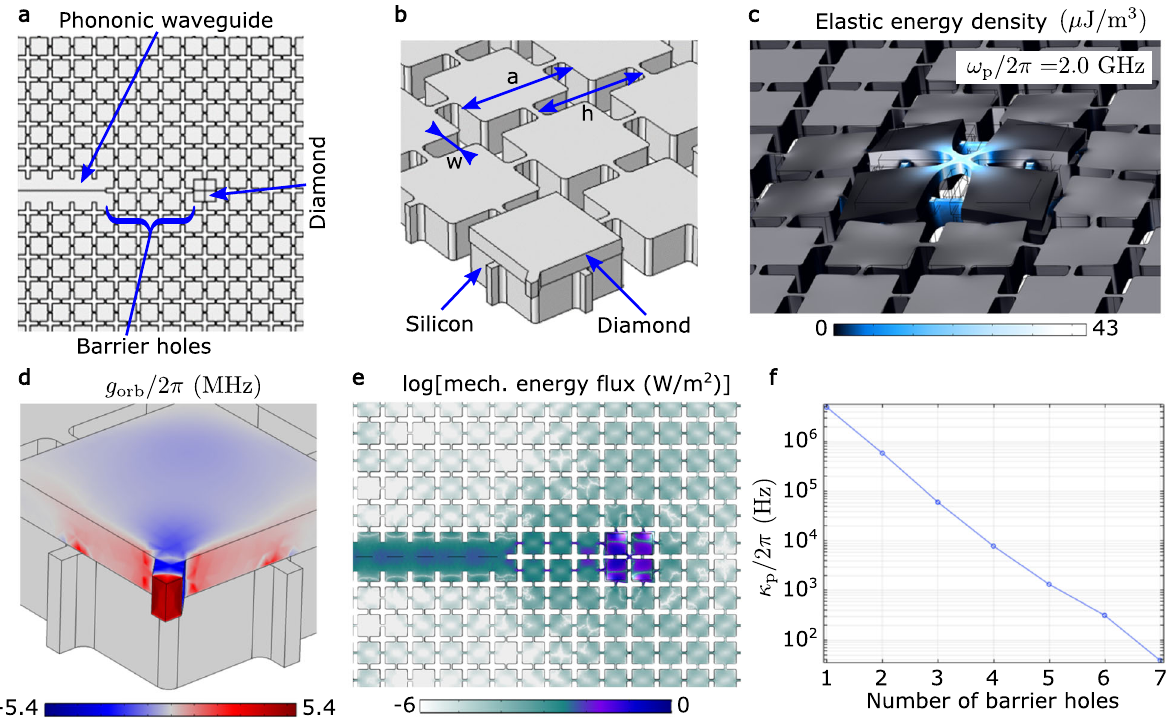
Fig. 2 Silicon phononic cavity. a A mechanical resonator embedded in a phononic crystal is separated from a phononic waveguide by a number of barrier holes. It is capped by a thin diamond layer placed over the silicon layer. b A close-up of one quarter of the silicon-diamond structure with dimensions a = 800 nm, h = 0.94 a , and w = 0.2 a . The silicon (diamond) layer thickness is t Si = 250 nm ( t D = 100 nm). The width of the thin rectangular diamond interconnects is w D = 70 nm. c The elastic energy density of the cavity mode is concentrated in the thin constriction of the diamond layer. The geometry of the cavity is arti fi cially distorted along the coordinate of the mechanical mode. d The coupling rate between the mechanical mode and the electron spin calculated as g orb ≈ ( ϵ xx − ϵ yy ) d , with d ≈ 1 PHz/strain being the strain susceptibility of SiV − defect. e The mechanical energy fl ux of the combined eigenmode of the mechanical cavity and the waveguide. f Mechanical damping κ p of the phononic cavity as a function of the number of barrier holes separating it from the phononic